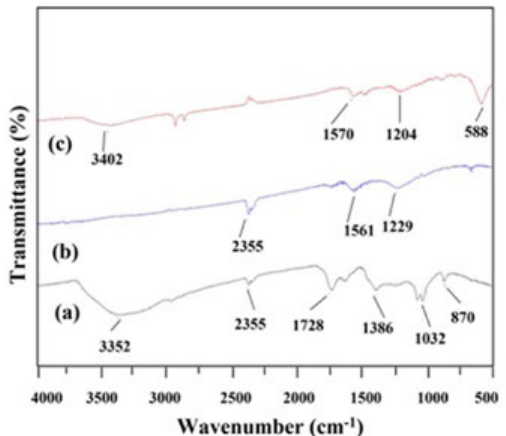
Fig. 4: FT-IR spectrum of (a) GO (b) NG, and (c) NG@ CoFe